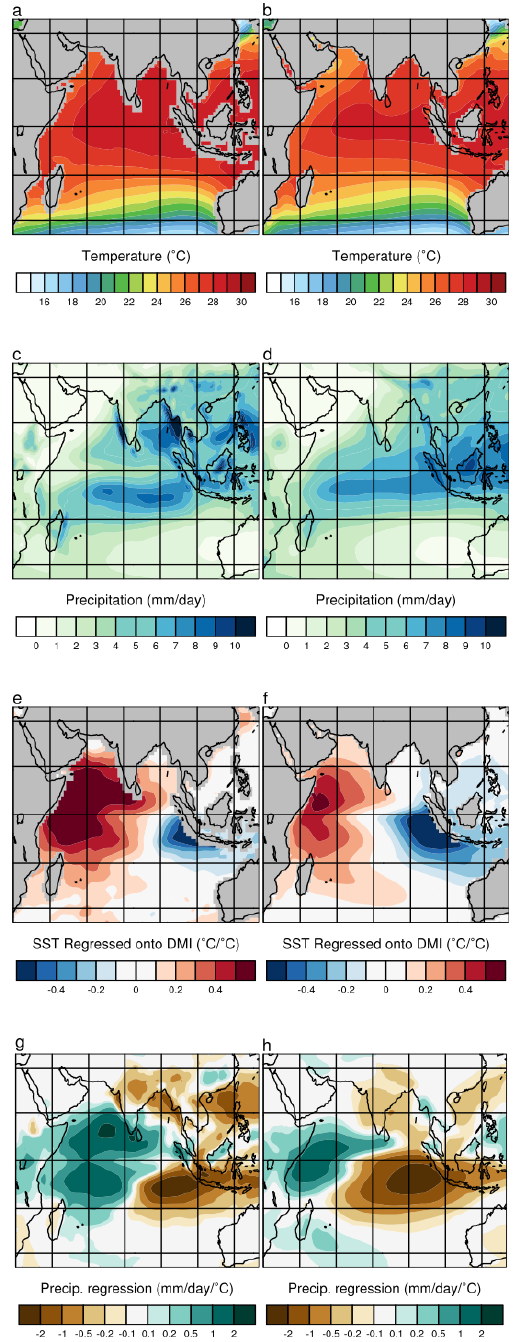
Figure 1. Comparison between the observed climate and the PMIP ensemble. The left-hand side is taken from the 20th-Century Re- analysis (Slivinski et al., 2019), with the ensemble mean of the preindustrial control simulations on the right. The rows present the annual mean sea surface temperatures (a, b) , annual mean precipi- tation (c, d) , IOD pattern computed by regressing the monthly SST anomalies against the DMI ( e, f ; Sect. 2.3), and the rainfall anoma- lies associated with IOD variations (g, h)